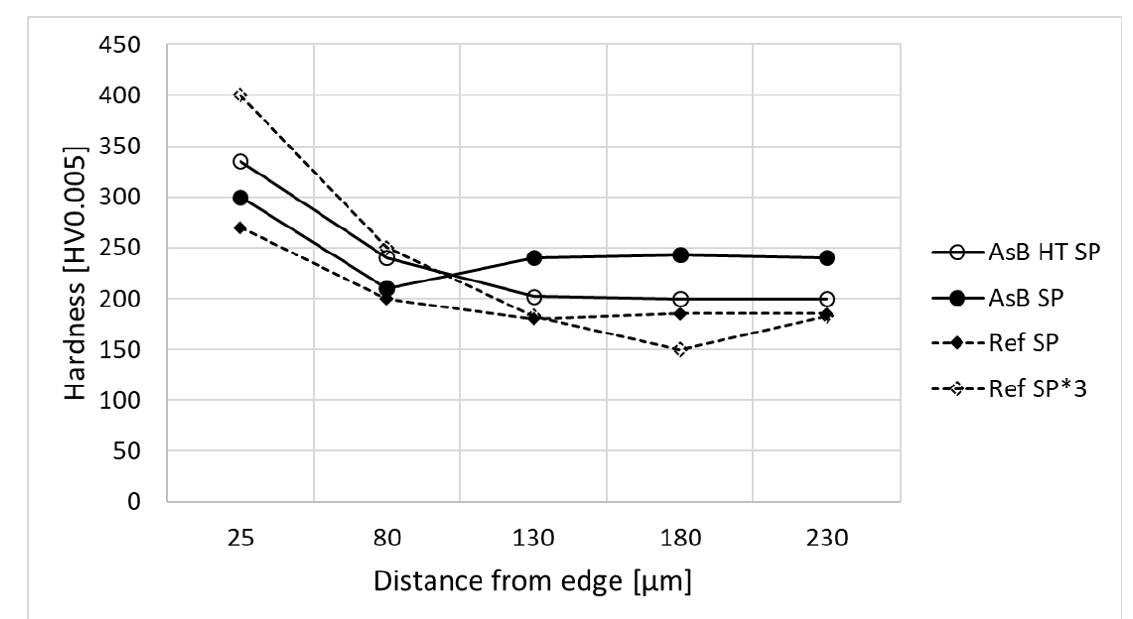
Figure 6. Hardness depth profiles of the cross-sectional samples: AsB HT SP, AsB SP, Ref SP (1 s peening) and REF SP (3 s peening).